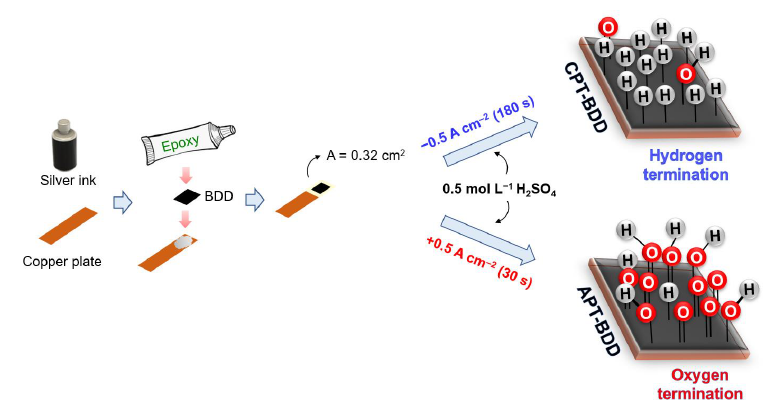
Figure 2. Scheme of boron-doped diamond (BDD) electrode assembly for electrochemical measurements and obtaining of cathodically pretreated (CPT-BDD) and anodically pretreated (APT-BDD) BDD electrodes.